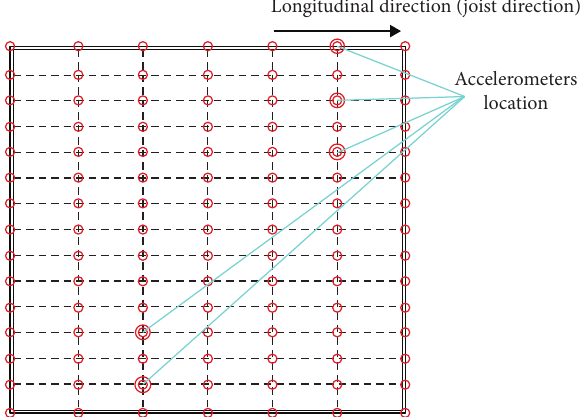
Figure 4: The measurement grid of the test floors and response measurement locations.